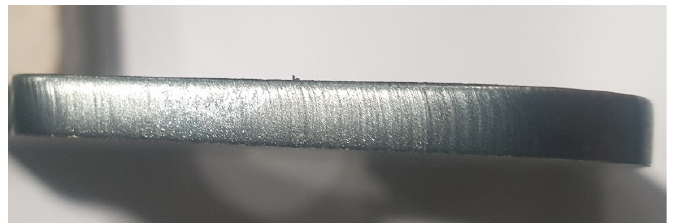
Figure A4. Edge surface quality of the cut 25 mm mild steel workpiece.